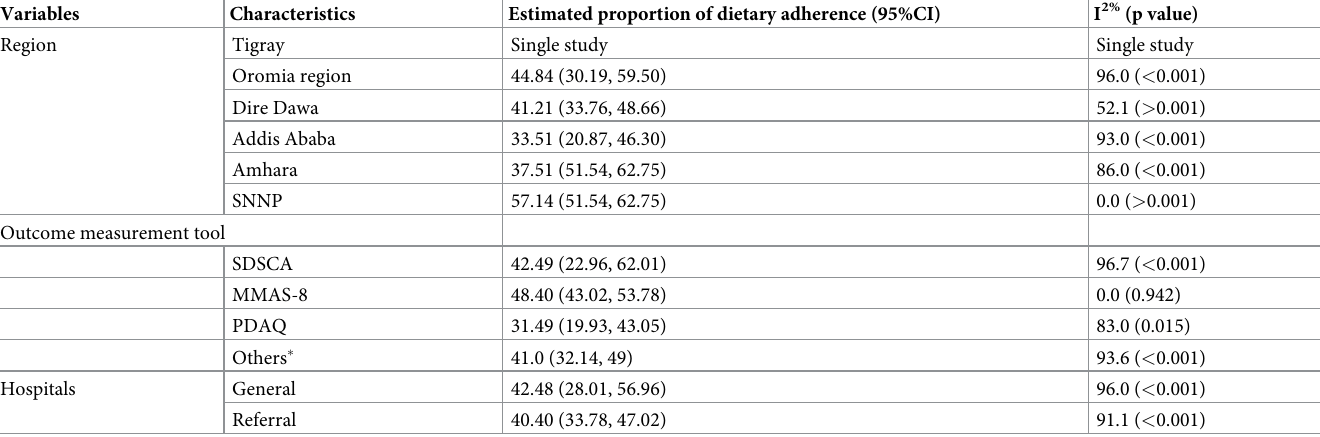
Table 2. Sub-group analysis of dietary adherence based region, hospital and outcome measurement tool in Ethiopia from 2012 to 2020.